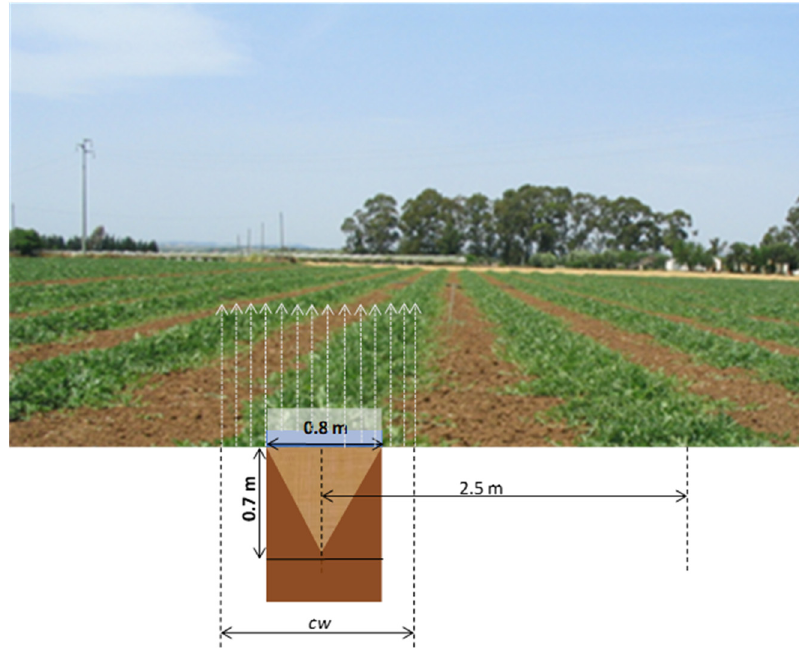
Figure 1. Photo of a watermelon field at Castellaneta (TA, Italy) and a schematic layout of the water/soil/plant domain. The isosceles triangle indicates the maximum root growth, the brown rectangle the soil domain in which the one-dimensional soil water fluxes take place, and the vertical grey arrows the transpirative fluxes of watermelon. cw is the canopy width measured during the monitored cropping cycle.